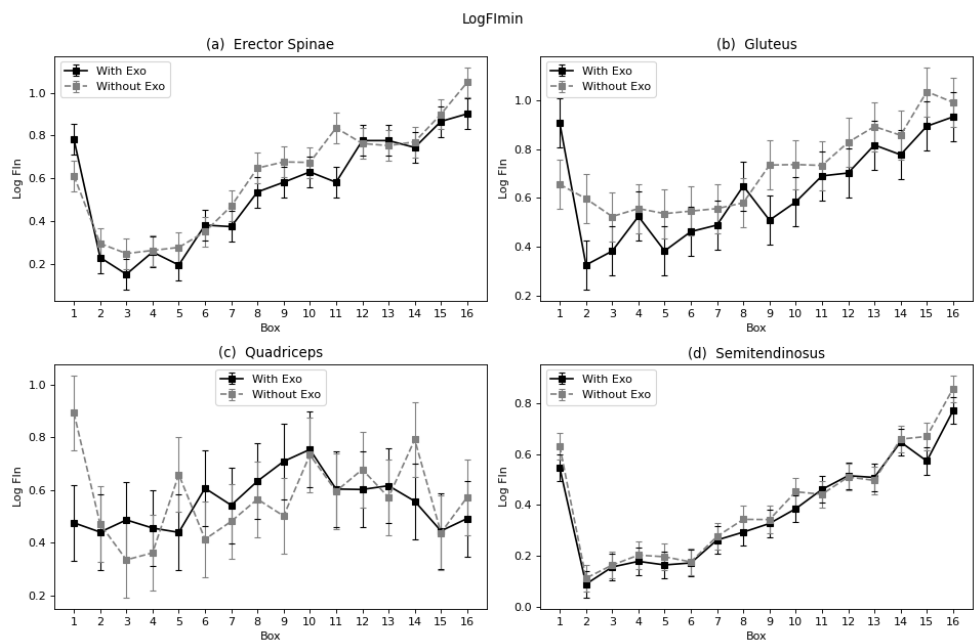
Figure 9. Marginal mean curves with the standard error bars of Log(FImin) parameter throughout the 16 boxes for all four muscles: ( a ) Erector Spinae, ( b ) Gluteus, ( c ) Quadriceps, and ( d ) Semitendinosus. Table 2. Percentage reduction in joint percentiles and range caused by the exoskeleton with their interval of confidence. The table shows the figures where the p -values are below 0.05. Lumbar % Right Hip % Right Knee % P RoM Flexion Extension − 3 ± 1 P 5 Rotation − 8 ± 5 P 5 Flexion Extension − 5 ± 3 P RoM Rotation − 39 ±